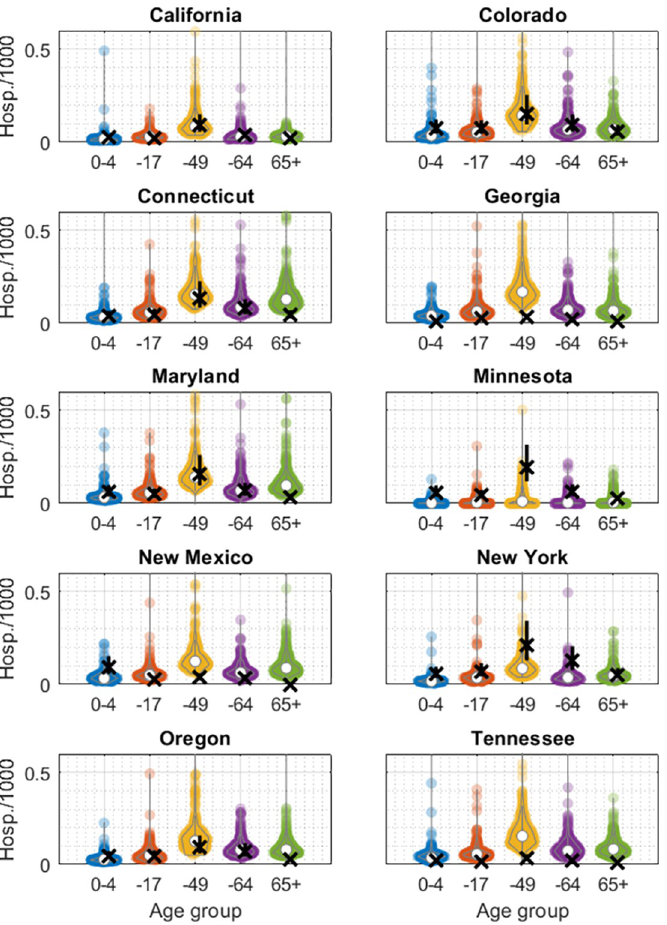
Fig 3. Model projections for cumulative hospitalisations in the fall wave. Each panel shows a different state. Crosses in black show data, vertical black lines show the 90% range of hospitalisation multipliers as given in [14], and coloured points show model-based projections, with each point representing the result of a single sample from the posterior